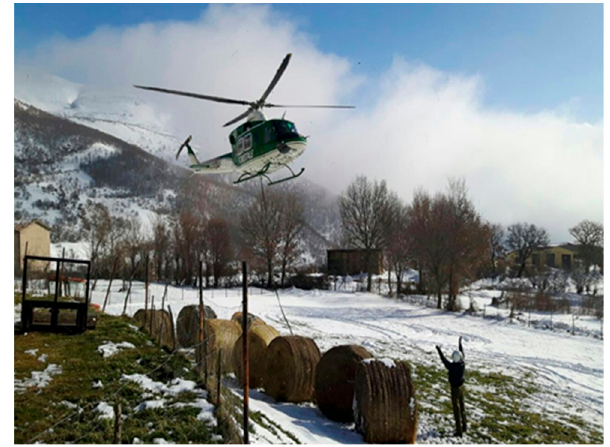
Figure 3. Distribution of farm feed to farms reporting urgent supply needs. Source: Istituto Zooprofilattico Sperimentale dell’Abruzzo e del Molise “G. Caporale”.